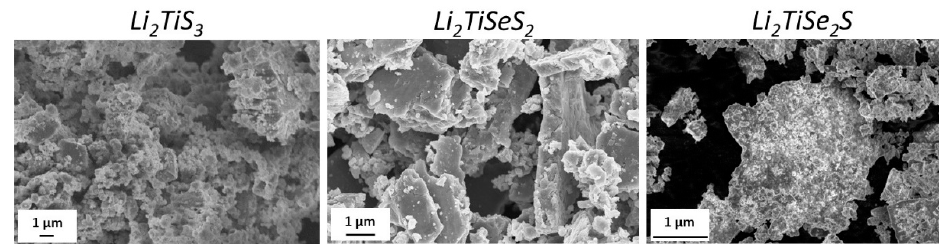
Figure 3. SEM images of Li 2 TiSe x S 3 − x (0 ≤ x ≤ 2) materials. All powders were composed of agglomerates of primary nanoparticles, and, curi- ously, the Li 2 TiSeS 2 agglomerates tended to have a plate-like morphology. (Li 2 TiSeS 2 and Li 2 TiSe 2 S) were investigated and compared in half-cells (Figure 4).